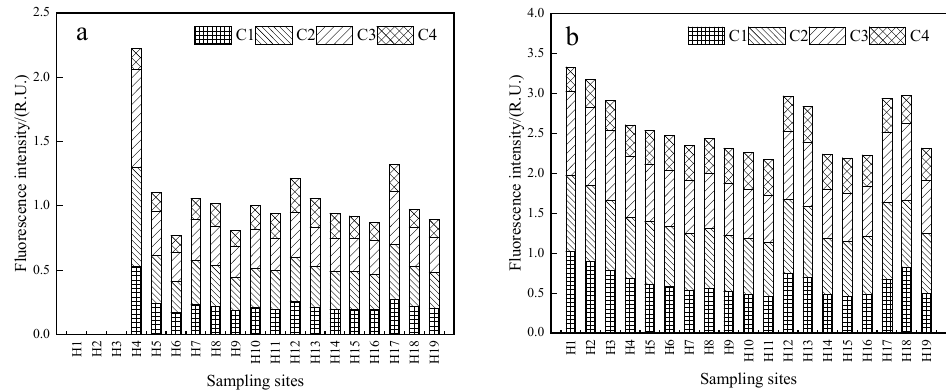
Figure 6. Fluorescence intensities of four fluorescent components: ( a ) Dry season; ( b ) Wet season.